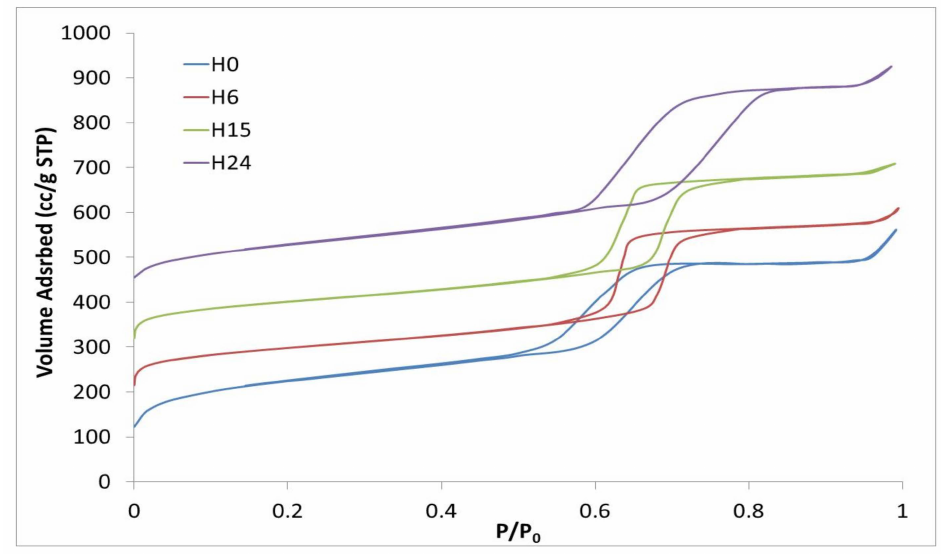
Figure 2. 77K N 2 adsorption isotherms of the samples prepared at different hydrothermal treatment times (samples H6, H15 and H24 are offset vertically by 100, 200 and 300 cm 3 /g STP,